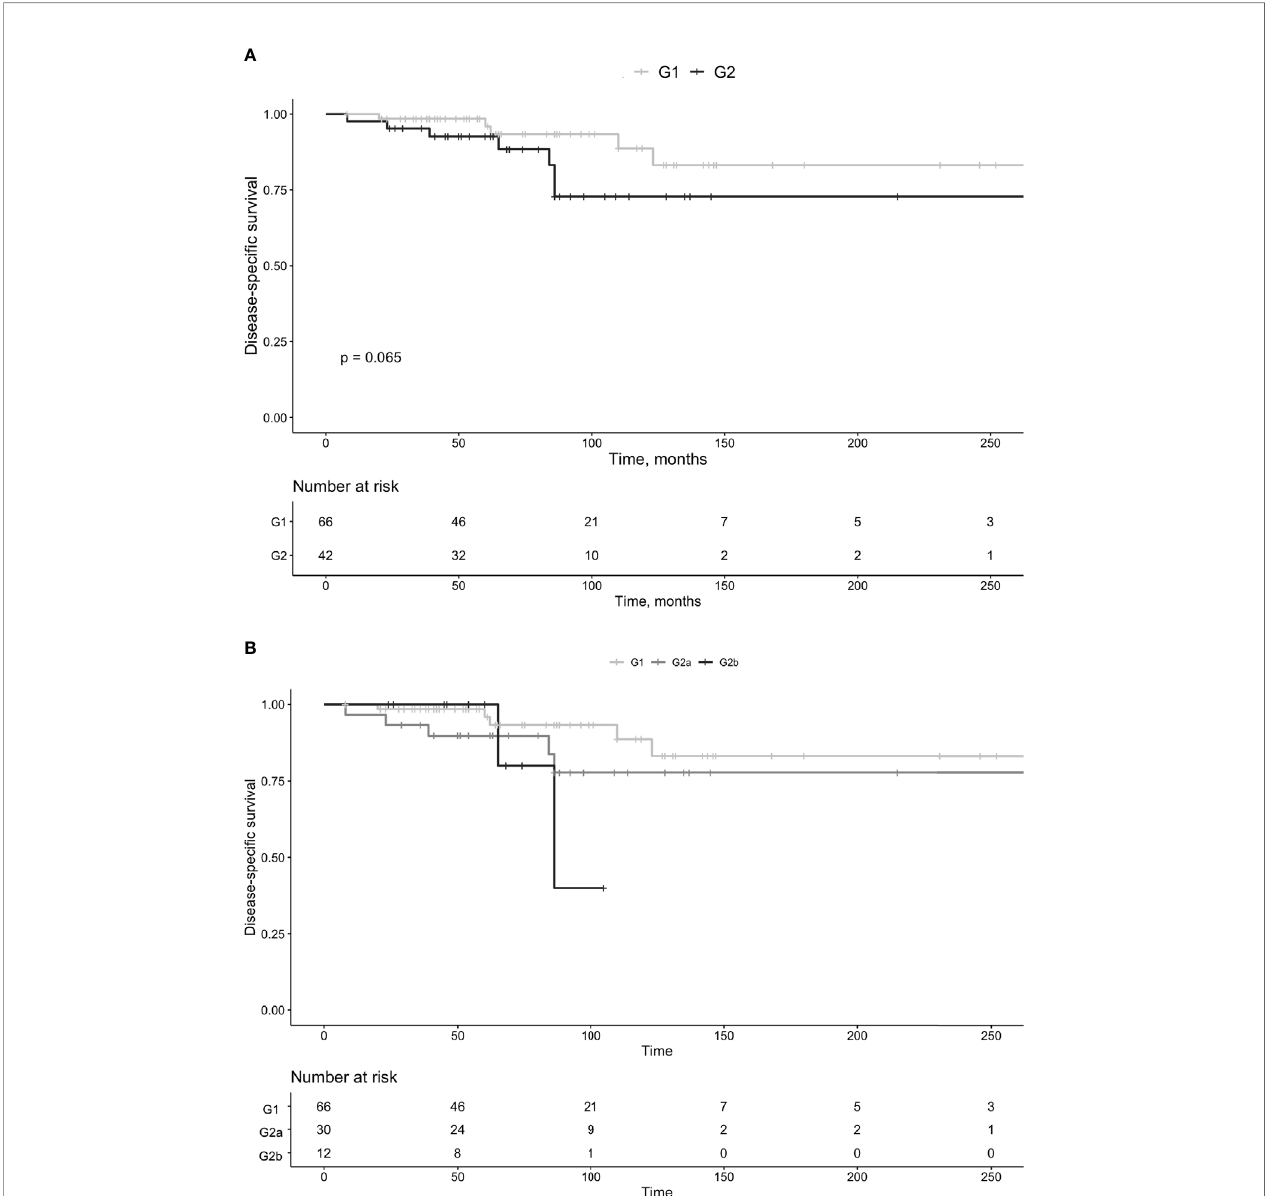
FIGURE 5 | Survival in patients with pan-NETs, divided in G1 and G2 tumors (A) and G1, G2a and G2b (B)